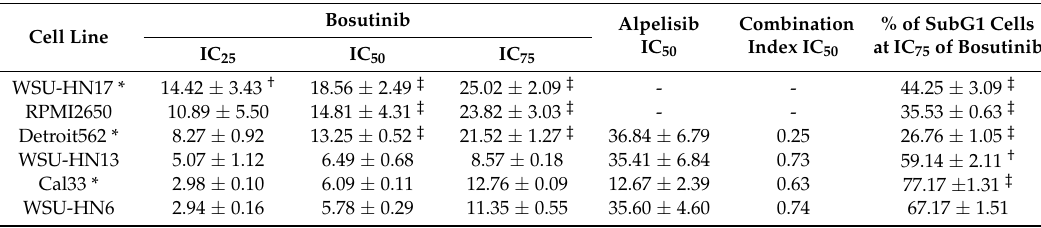
Table 2. Inhibitory concentration (IC) values for Bosutinib and Alpelisib ( µ M), combination index for both drugs at their IC 50 and percentage of cells with SubG 1 DNA content when treated with the IC 75 of